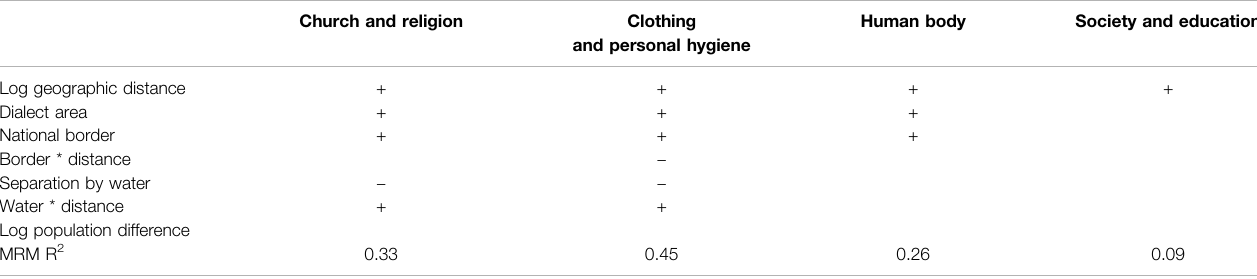
TABLE 10 | Signi fi cant explanatory factors (+ for positive coef fi cients; − for negative coeffecients) and R 2 -values across the four semantic domains based on the multiple regression of distance matrices (MRM) analyses. Church and religion